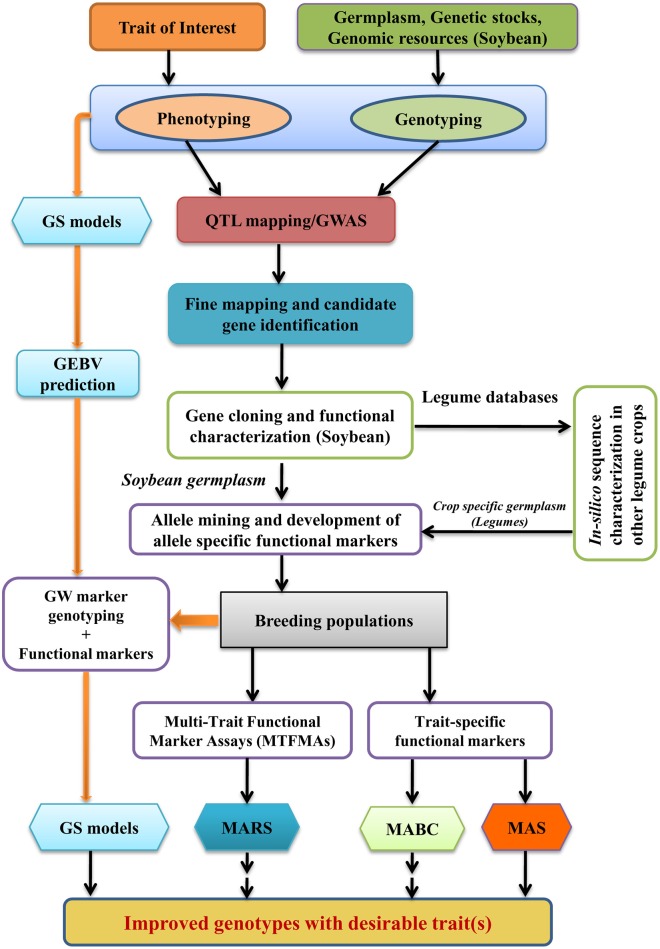
Strategy for characterization of genes underlying QTLs in soybean and translational genomics enabled breeding in legume crops (GWAS, Genome-wide association studies; MABC, Marker-assisted backcross breeding; MAS, Marker-assisted selection; MARS, Marker-assisted recurrent selection; GS, Genomic selection; GW, Genome wide; GEBV, Genomic estimated breeding values).